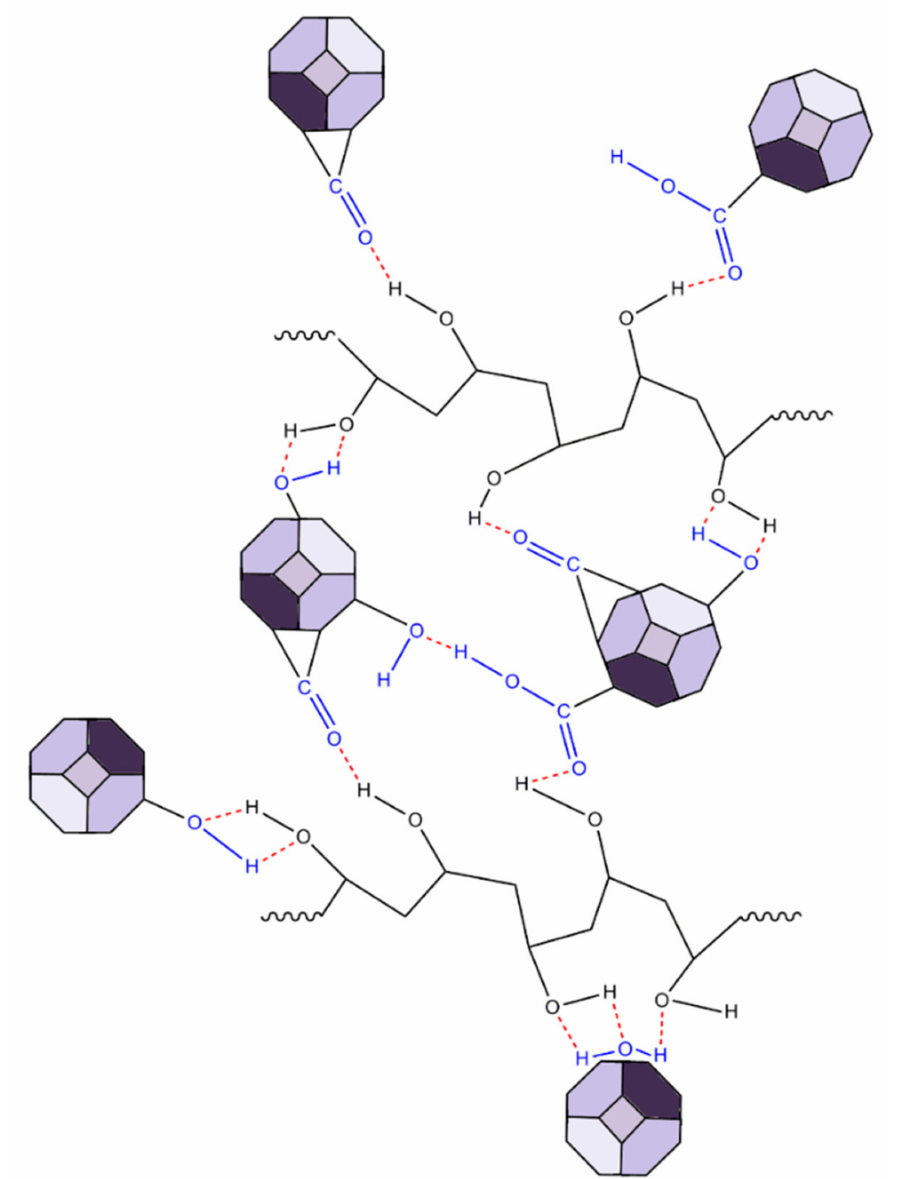
Scheme 1. Model scheme of the PVA and ND nanocomposite